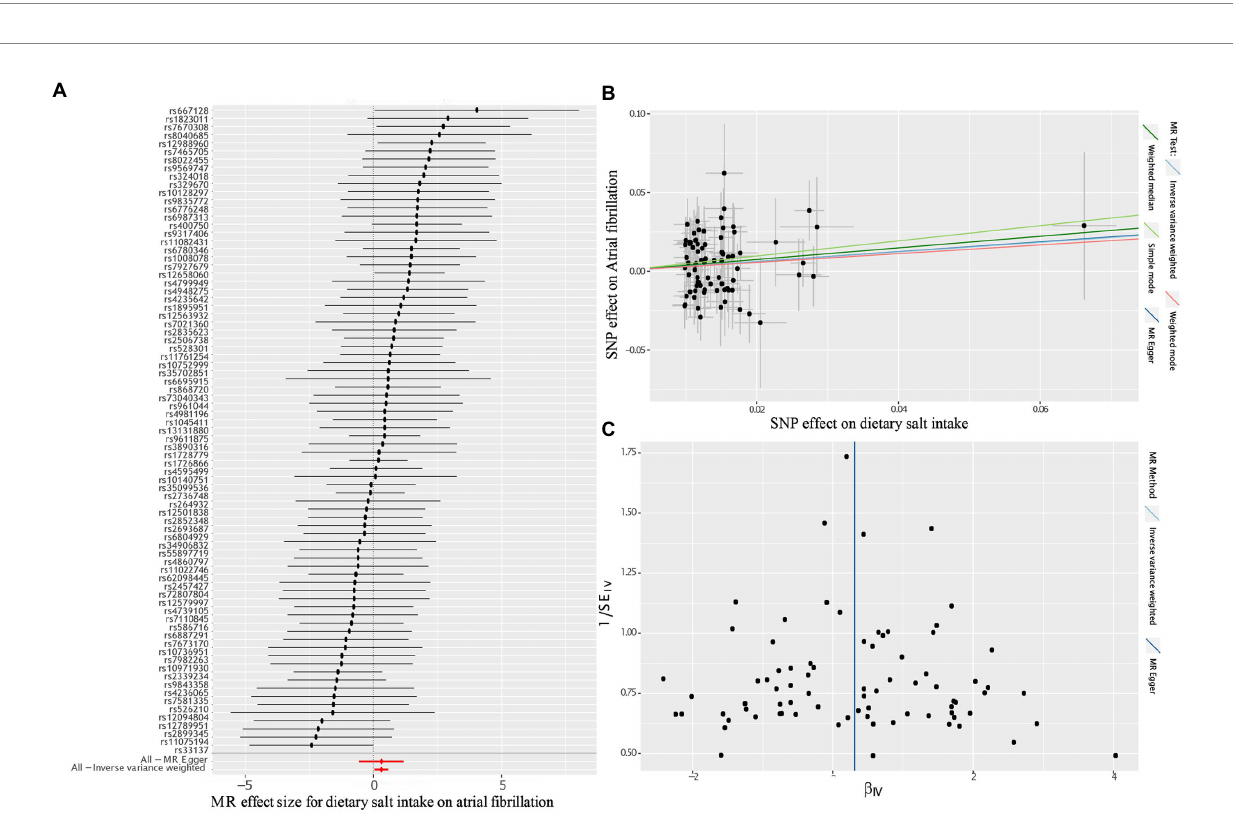
FIGURE 3 Forest plot, Scatter plot and funnel plot of the effect of dietary salt intake on atrial fibrillation. (A) Forest plot shows the odds ratio (OR) and 95% confidence interval (CI) of each SNP assessed in the present study; (B) Scatter plot for MR analyzes of the association between dietary salt intake an atrial fibrillation. The slope of each line corresponds to the estimated association of different MR methods; (C) Funnel plot shows the estimates of precision (1/SE) and Wald ratios for each SNP; SNP, single nucleotide polymorphism; MR, Mendelian